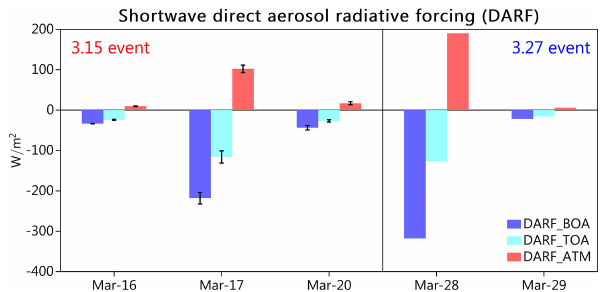
Figure 9. Daily variation of the shortwave direct aerosol radiative forcing (DARF) at Beijing-CAMS site during the two SDS events.